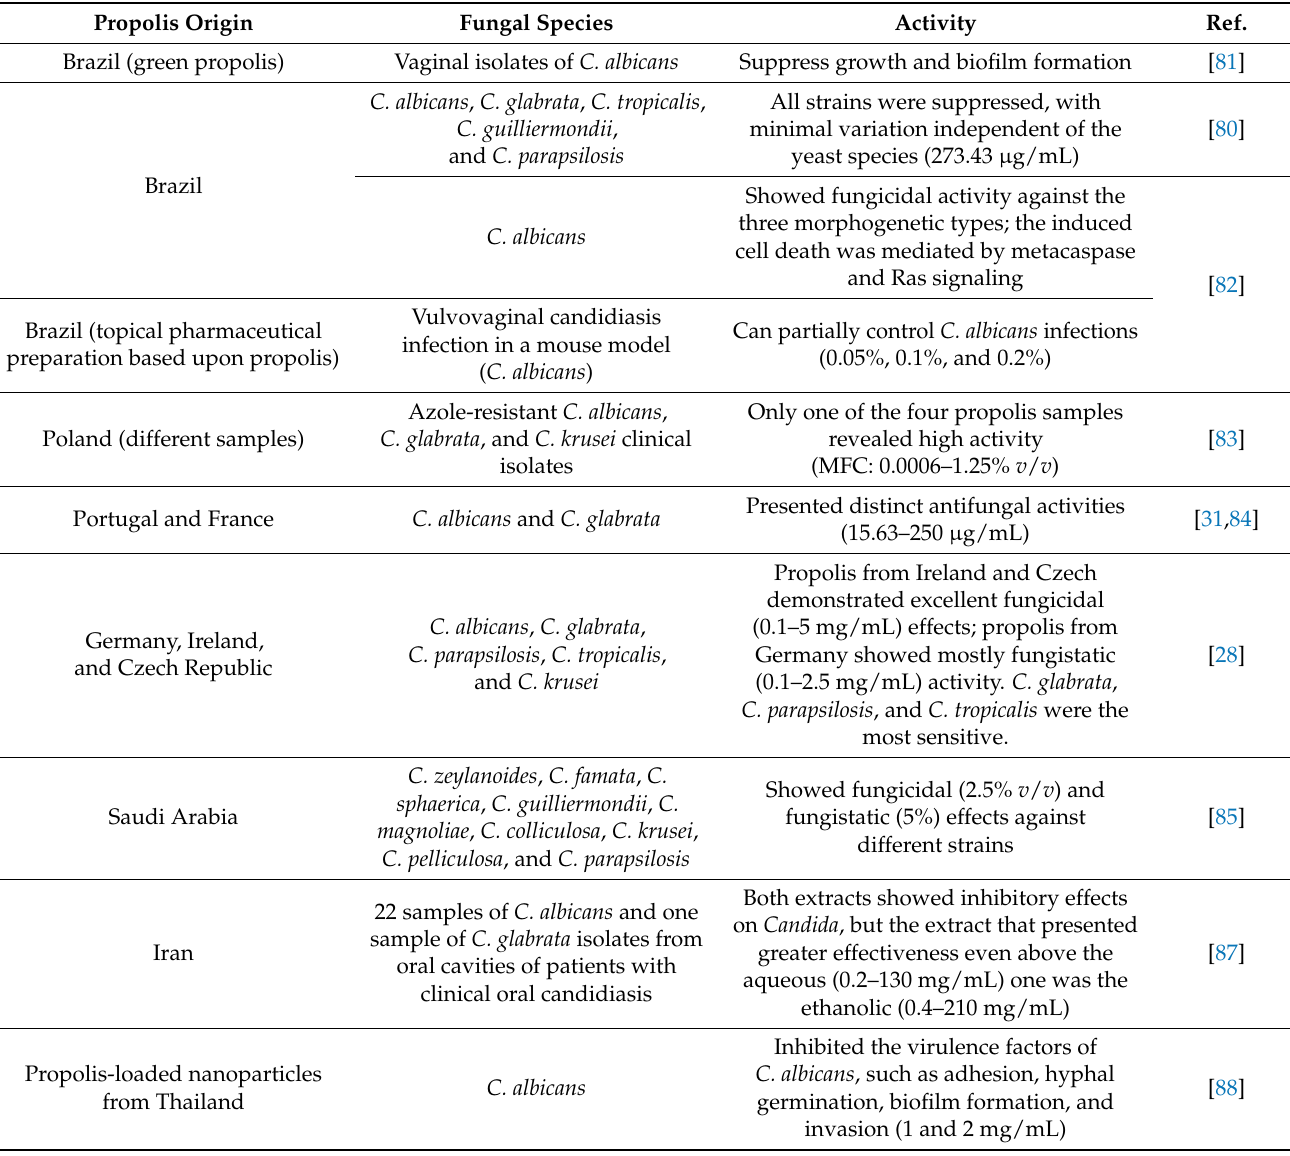
Table 8. Anti- Candida activity of different propolis around the